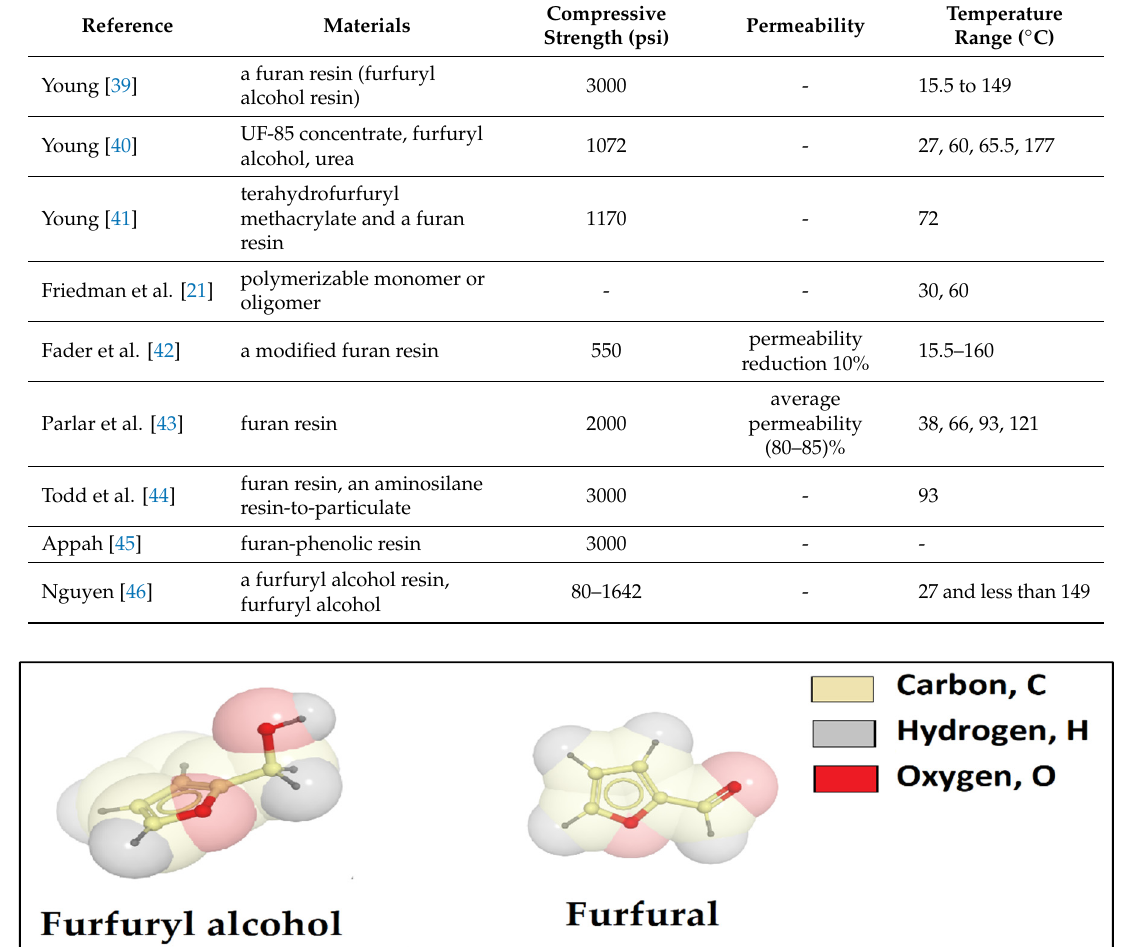
Figure 4. Chemical structure of furfuryl alcohol and furfural.